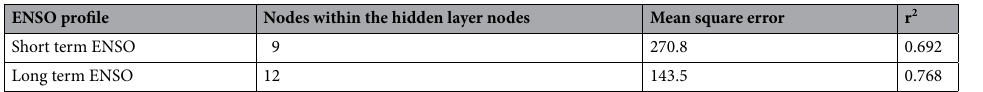
Table 1. Architecture of the hidden layer and network precision for Bayesian neural networks constructed to predict cacao crop yield using either short term (1–9 months) or long term (1–25 months) ENSO